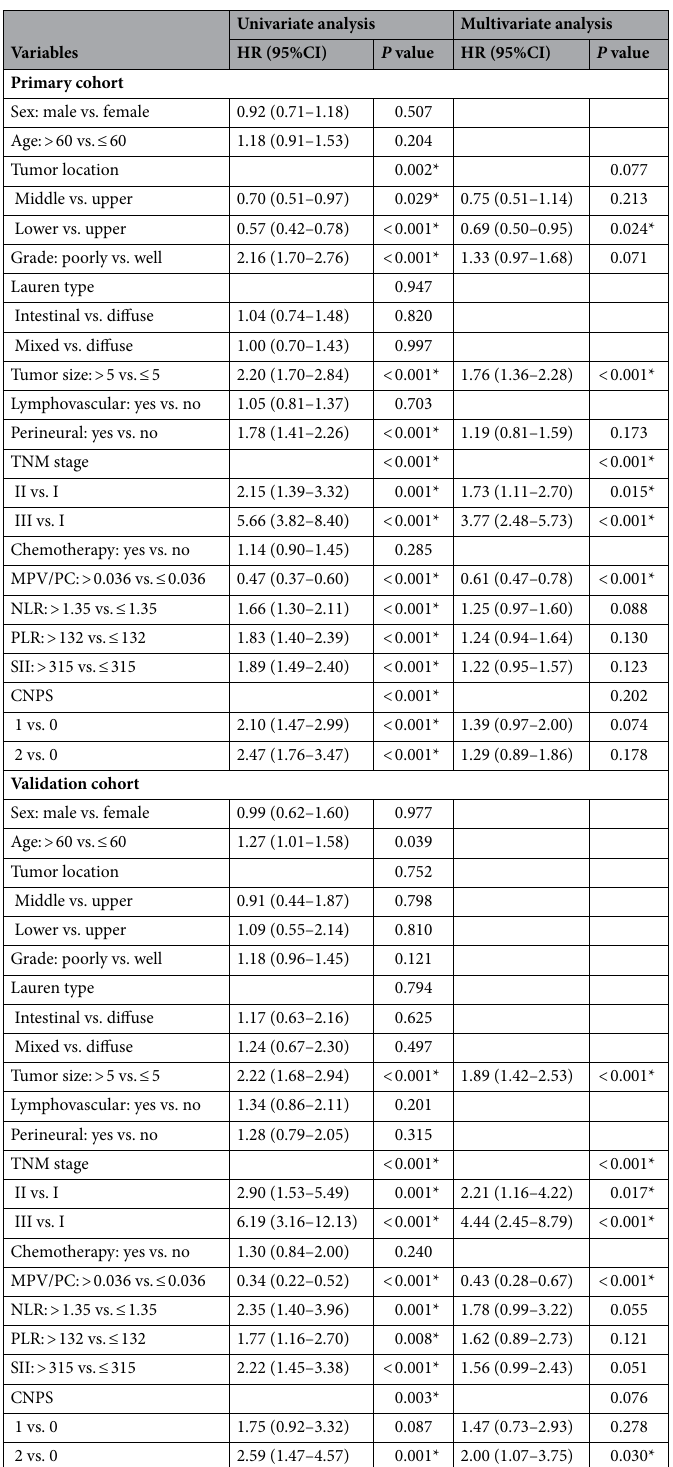
Table 2. Univariate and multivariate cox regression analyses for overall survival in patients with gastric cancer. TNM tumor, node, metastasis, AJCC American Joint Committee on Cancer, MPV/PC mean platelet volume to platelet count, NLR neutrophil-to-lymphocyte ratio, PLR platelet-to-lymphocyte ratio, CNPS combined neutrophil-platelet score, SII systemic immune-inflammation index. *Represents a statistically